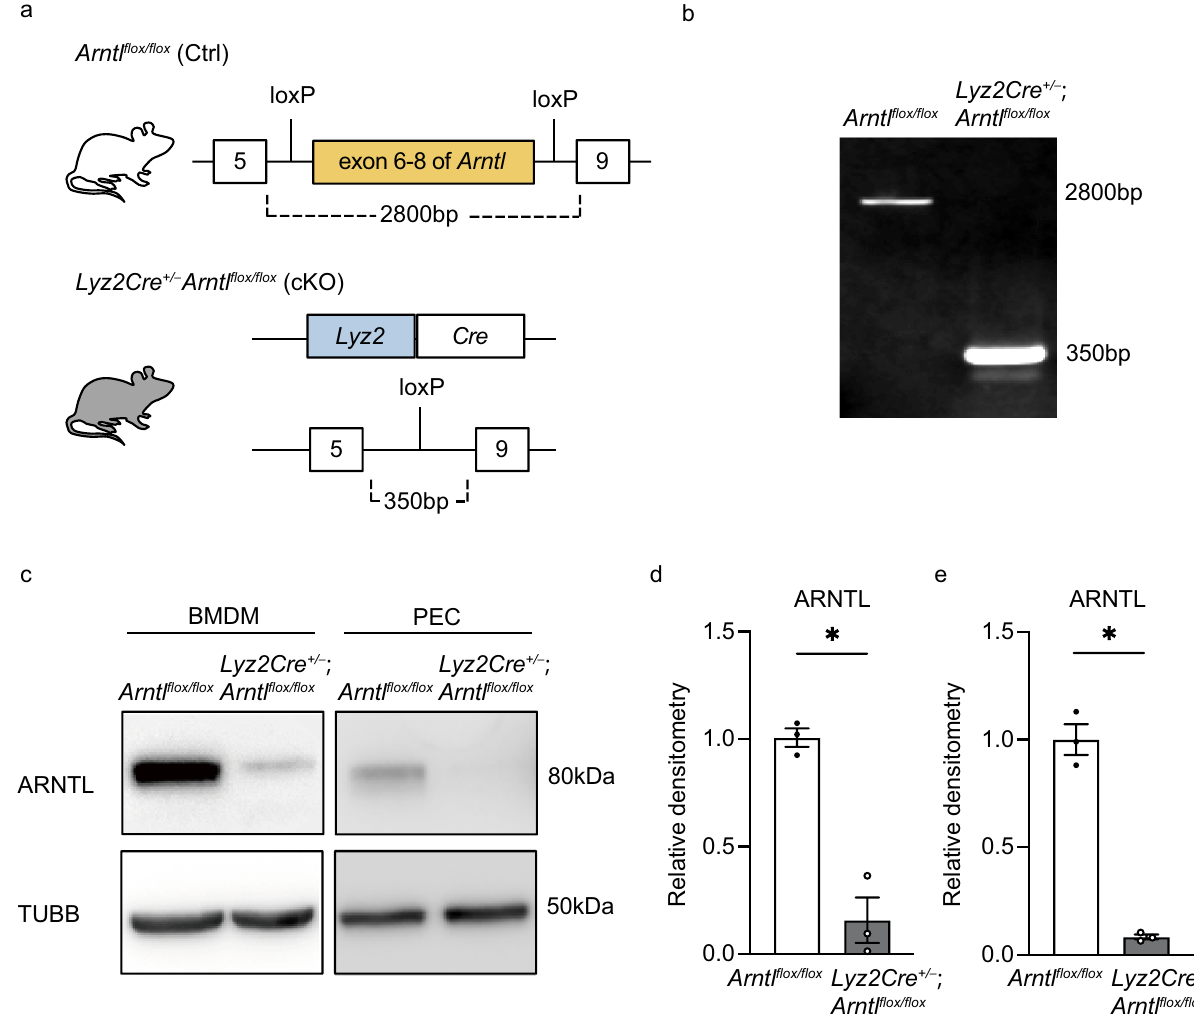
Figure 1. Generation of the myeloid cell-specific Arntl knockout model. ( a ) Schematic representation of the gene targeting method used to generate the myeloid cell-specific aryl hydrocarbon receptor nuclear translocator-like ( Arntl ) knockout mice. ( b ) Arntl genotyping. PCR of the floxed (wild-type) allele produced a 2800-bp product from control (Ctrl) bone marrow-derived macrophages (BMDM) DNA, whereas PCR of the deleted allele produced a 350-bp product from DNA in the conditional knockout (cKO) BMDM. Raw gel image is in Fig. S7. ( c ) Western blots of ARNTL and tubulin beta (TUBB) in BMDM and peritoneal exudate cells (PEC) from Ctrl and cKO mice. The grouping images of ARNTL and TUBB from different parts and exposures of the same membrane. Raw blot images are in Fig. S8. The results are representative of three independent experiments. ( d , e ); Densitometry of BMDM ( d ) and PEC ( e ) western blots from three independent experiments. Data are expressed as the means ± SEM. * p < 0.05 with unpaired two-tailed Student’s t